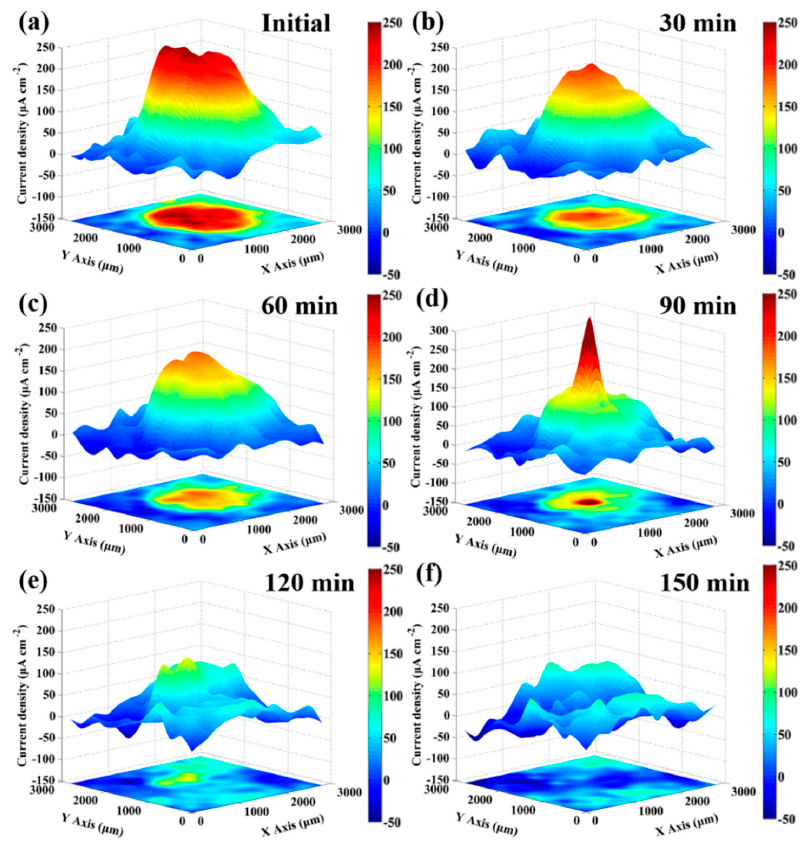
Figure 7. In-situ SVET 3D-maps of the ionic currents measured above the scratch in 3.5 wt % NaCl solution with different times: ( a ) initial; ( b ) 30 min; ( c ) 60 min; ( d ) 90 min; ( e ) 120 min; and ( f ) 150 min.